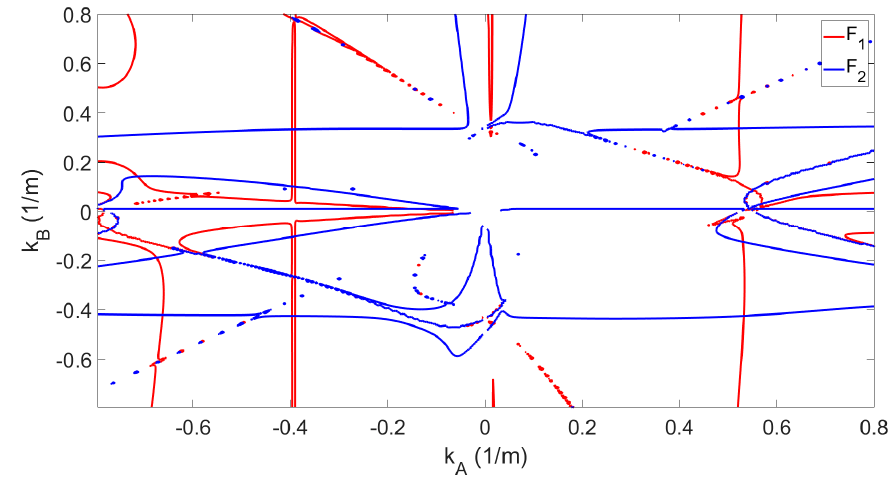
(cid:0) (cid:1) s − 1 .